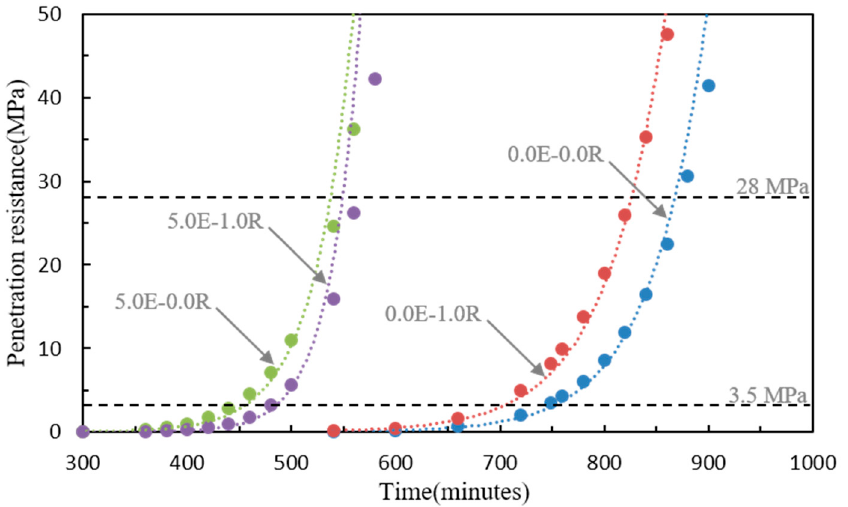
Figure 3. Setting properties of the HPC with various admixture contents.